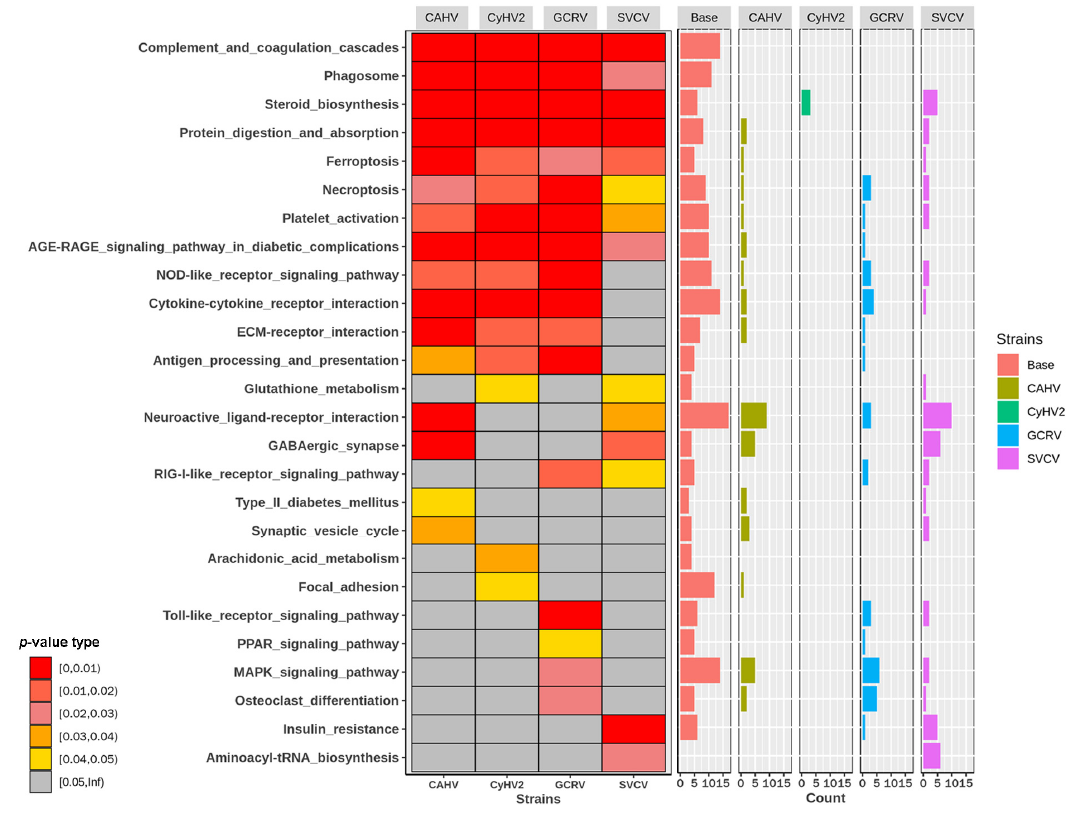
Figure 2. Diagrams of enriched pathways based on DEGs and PBGs in infections by four viruses, respectively. Heat map: The p -values of the enriched pathway based on the DEGs and PBGs per virus. Bar plot: The number of PBGs and non-PBGs per virus in each enriched